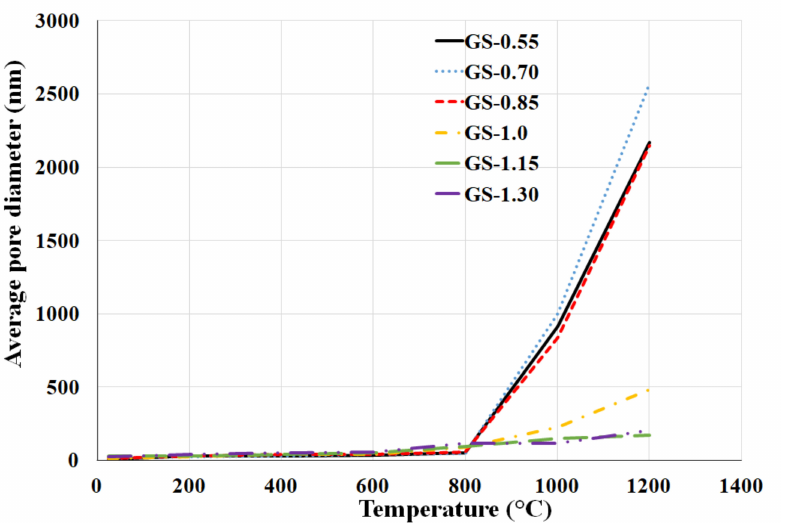
Figure 10. The influence of increasing temperature on the average pore diameter of geopolymer